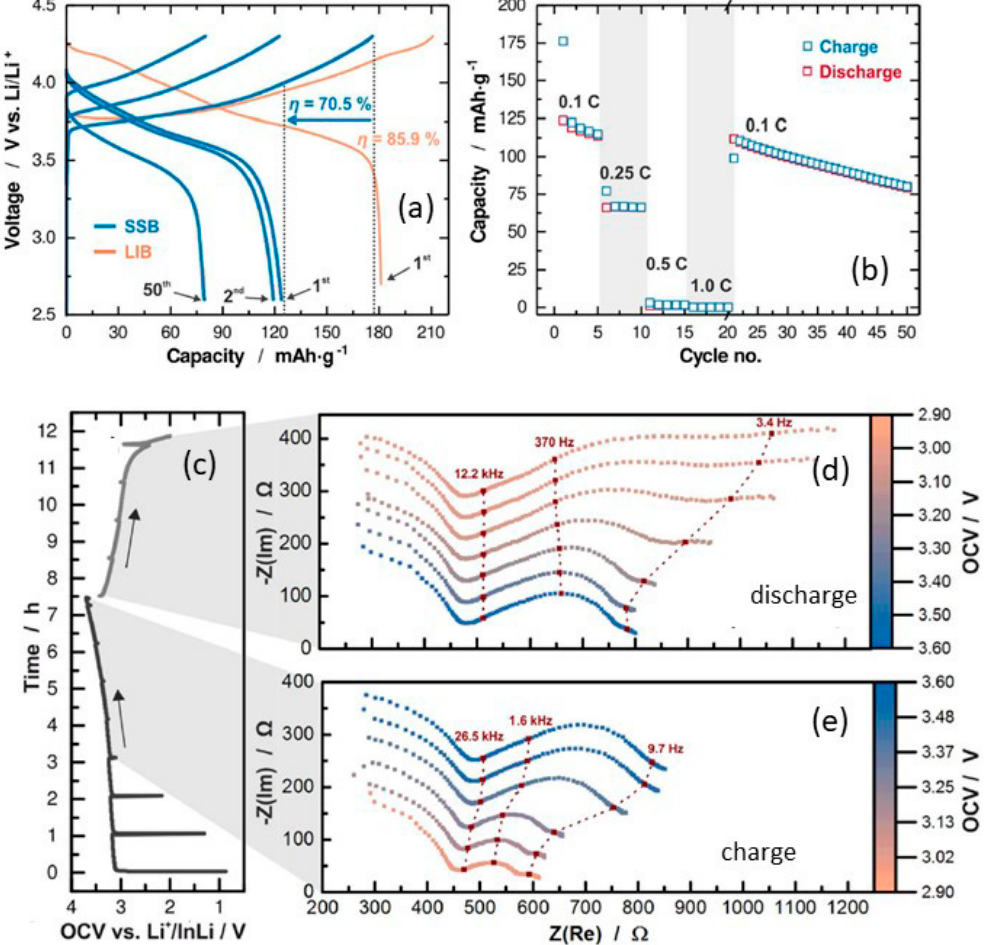
Figure 10. ( a ) Representative charge–discharge profiles of an ASSLB for the 1st, 2nd, and 50th cycle (blue). The ASSLB was cycled between 2.7 and 4.3 V vs. Li + / Li. The orange curve represents the 1st charge-discharge cycle of a liquid Li-ion battery (LIB) with NMC-811 as the cathode, and it was included for comparison. The current density for all cycles was 0.1C. ( b ) Rate test and long-term cyclability of the SSB at the current densities of 0.1, 0.25, 0.5, and 1C, followed by open-end cycling at 0.1C. A large